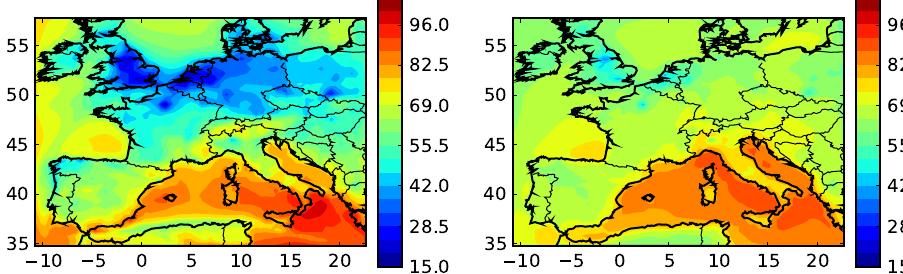
Fig. 7. Temporal average of ozone map for reference model 5 (left) and for model 76 of the 101-member ensemble (right).